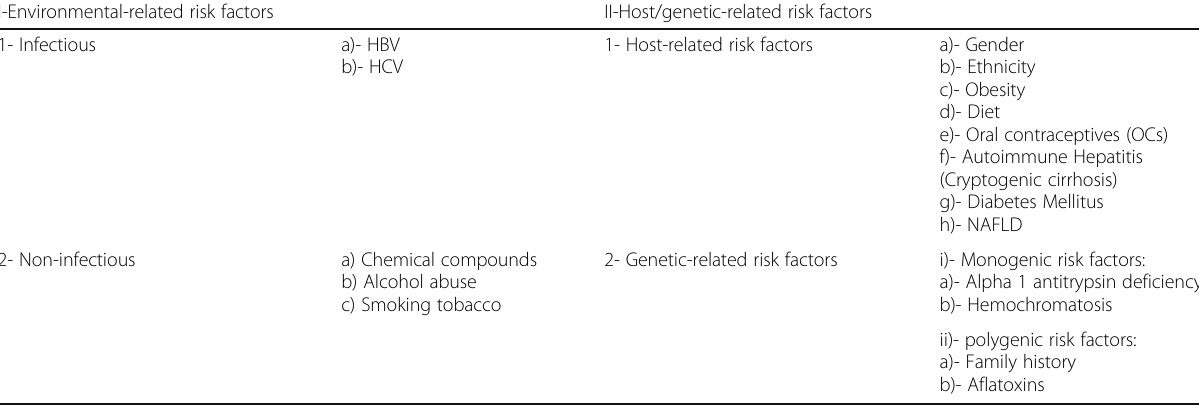
Table 1 Risk factors for HCC development I-Environmental-related risk